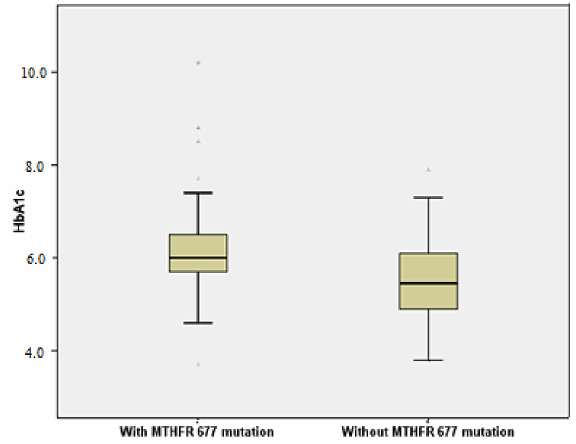
Figure 2. Patients with MTHFR C677T mutation have a high risk for increased HbA1c values (OR = 1.982, 95%CI = (1.171, 7.799)).